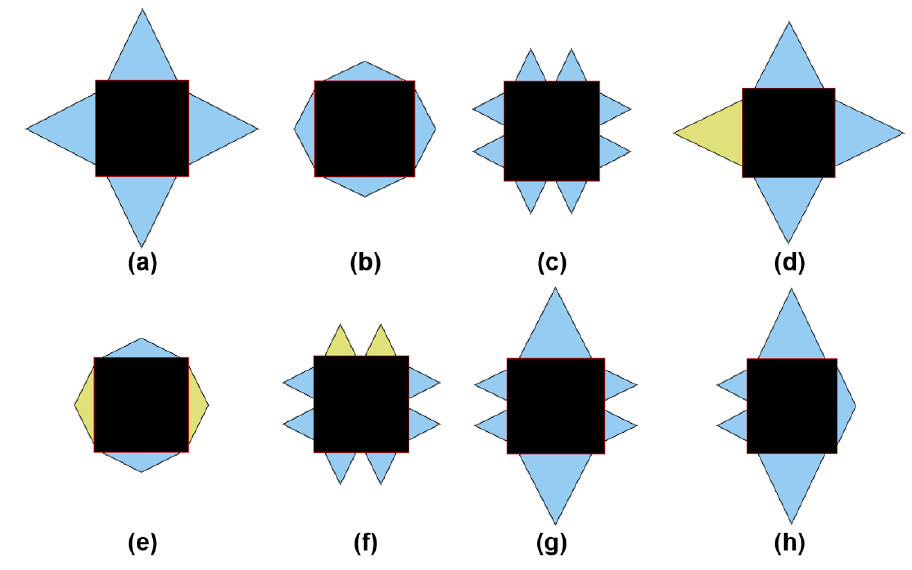
Figure 5. ( a – h ) Different arrangements of billet cooling sprays in continuous casting machines.